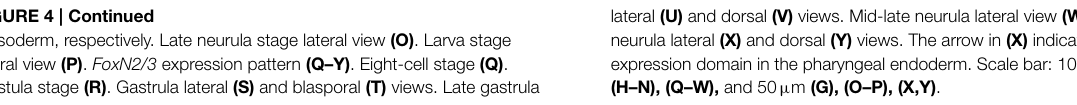
FIGURE 4 | Continued mesoderm, respectively. Late neurula stage lateral view (O) . Larva stage lateral view (P) . FoxN2/3 expression pattern (Q–Y) . Eight-cell stage (Q) . Blastula stage (R) . Gastrula lateral (S) and blasporal (T) views. Late